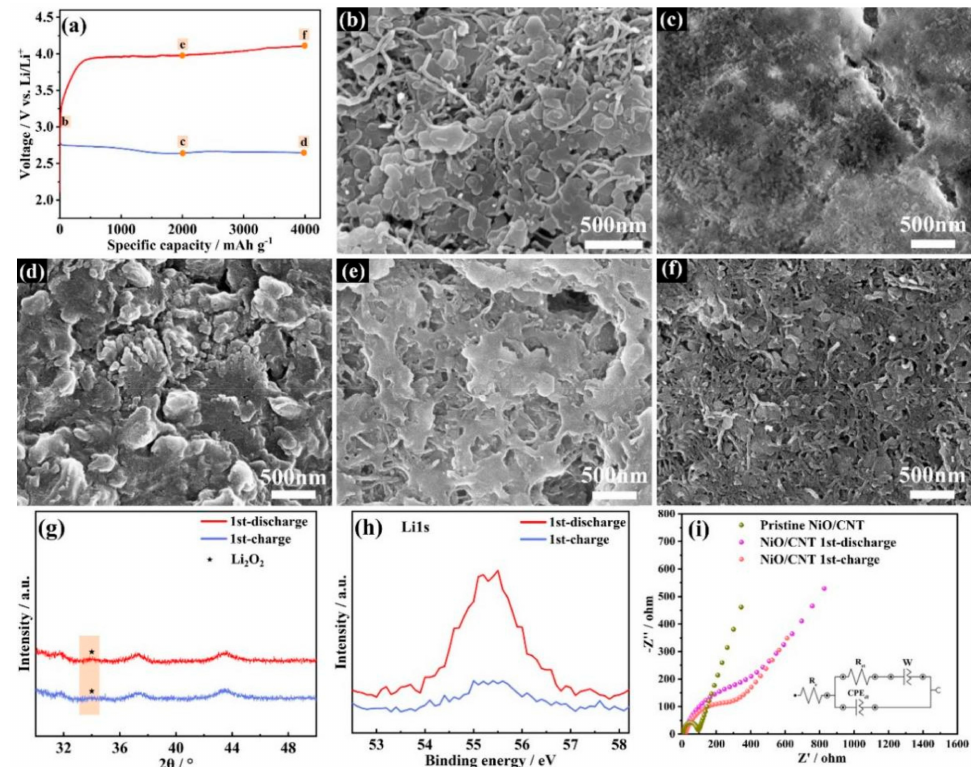
Figure 5. ( a ) The curves and SEM images of the CNT/NiO catalyst at different discharge– recharge depths at a current density of 100 mA g − 1 discharged (blue line) to ( b ) the initial stage, ( c ) 2000 mA h g − 1 ( d ) and 4000 mA h g − 1 , and recharged (red line) to ( e ) 2000 mA h g − 1 and ( f ) 4000 mA h g − 1 ; ( g ) XRD patterns and ( h ) Li 1s core peaks of the NiO/CNT catalyst after discharge and charge; ( i ) EIS of Li-O 2 battery with NiO/CNT catalyst at different